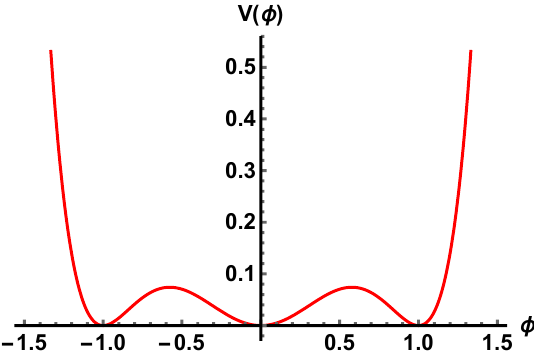
Figure 1. The potential (2.2) of the (cid:30) 6